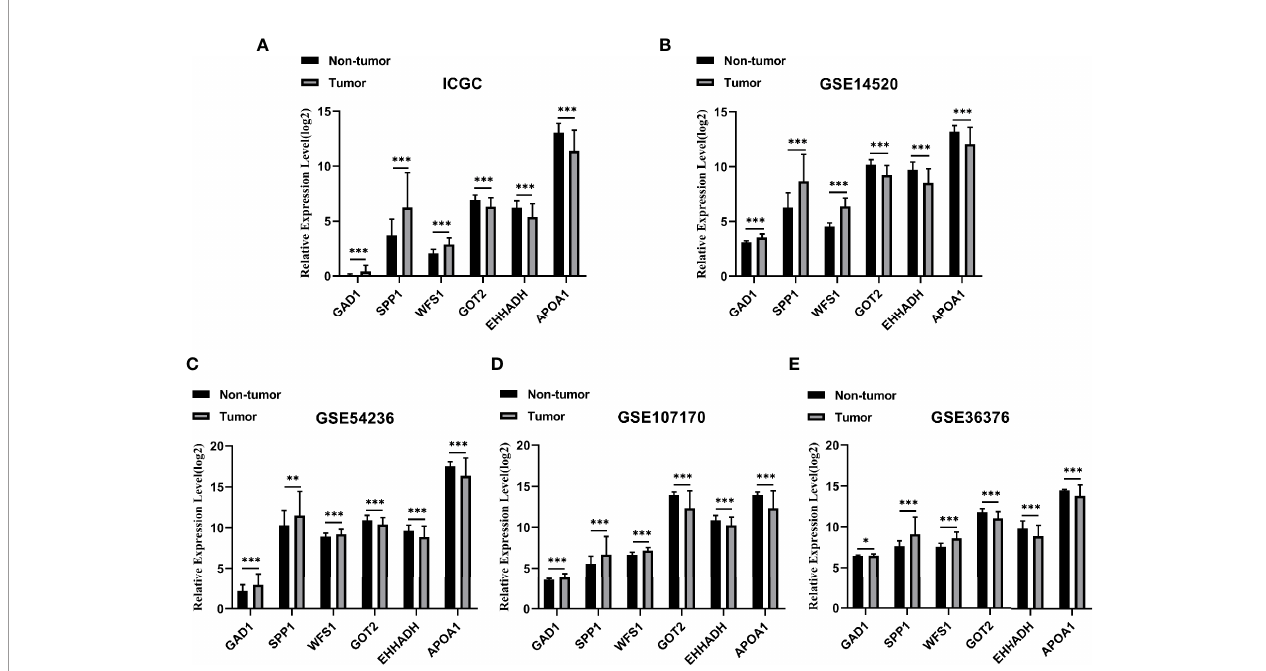
FIGURE 4 | Veri fi cation of the six speci fi cally expressed hub MRGs in fi ve datasets. (A) Validation of six hub genes in the ICGC database. (B) Validation of six hub MRGs in GSE14520. (C) Validation of six hub MRGs in GSE54236. (D) Validation of six hub MRGs in GSE107170. (E) Validation of six hub MRGs in GSE36376. (*P < 0.05; **P < 0.01; ***P < 0.001).